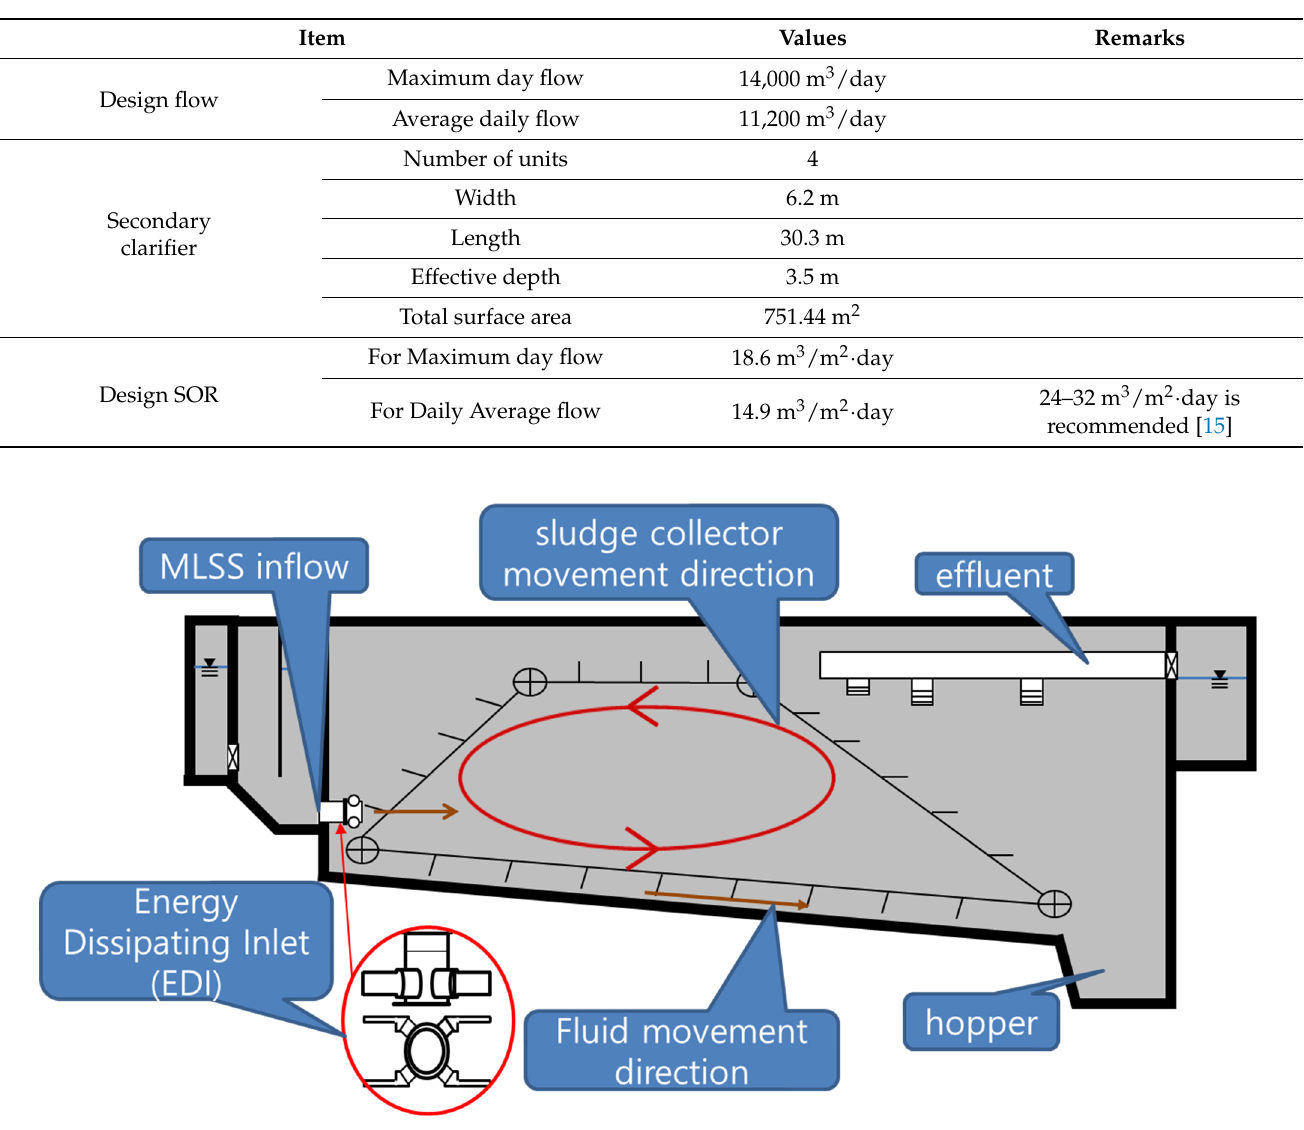
Figure 2. Longitudinal view of Gould Type I secondary clarifier and energy dissipating inlet (EDI) at plant B.